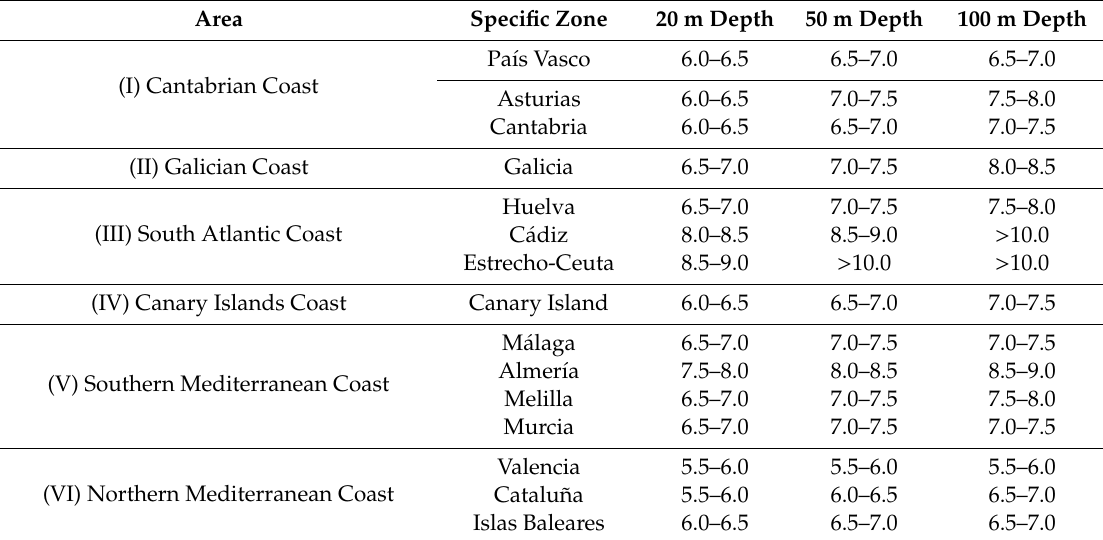
Table 1. Annual average wind speed, in m/s, in all the areas in the Spanish coast.